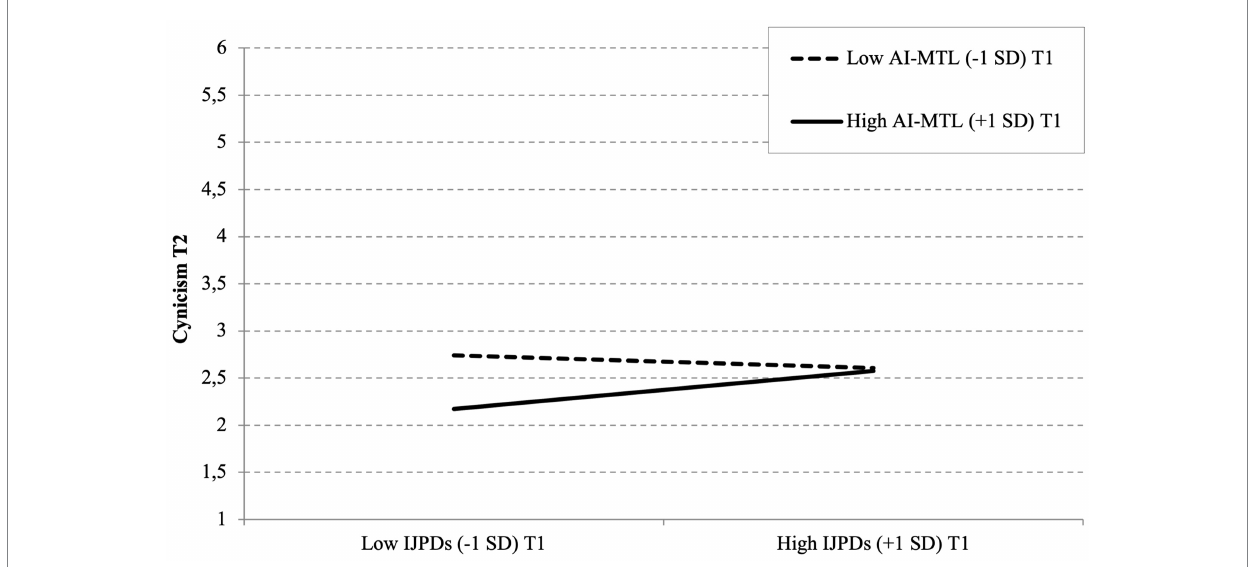
FIGURE 1 Two-way interaction effect between affective-identity motivation to lead (AI-MTL) at T1 and intensified job-related planning demands (IJPDs) at T1 on cynicism at T2 ( B coefficients are reported in the